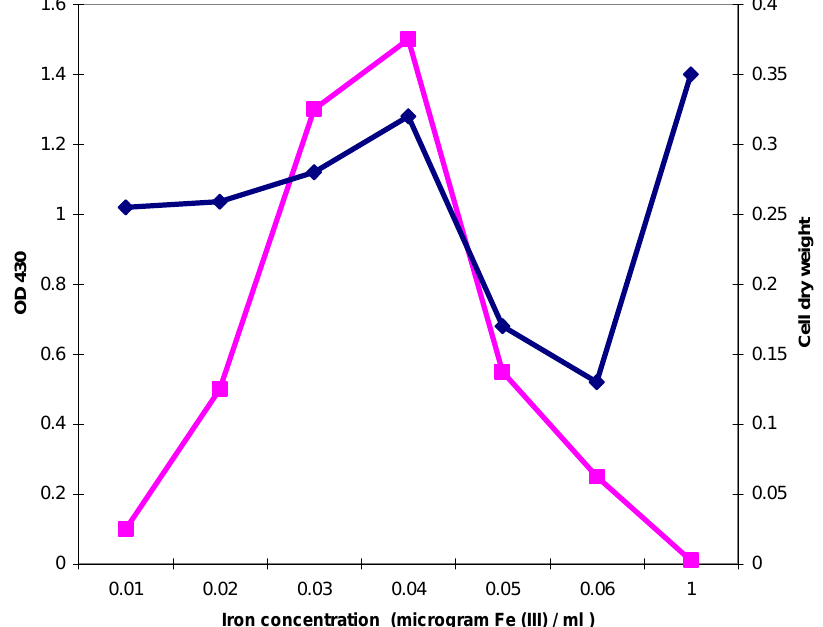
Figure 4. Detection of M. neoaurum exochelin production and corresponding cell dry weight in growth media containing various iron